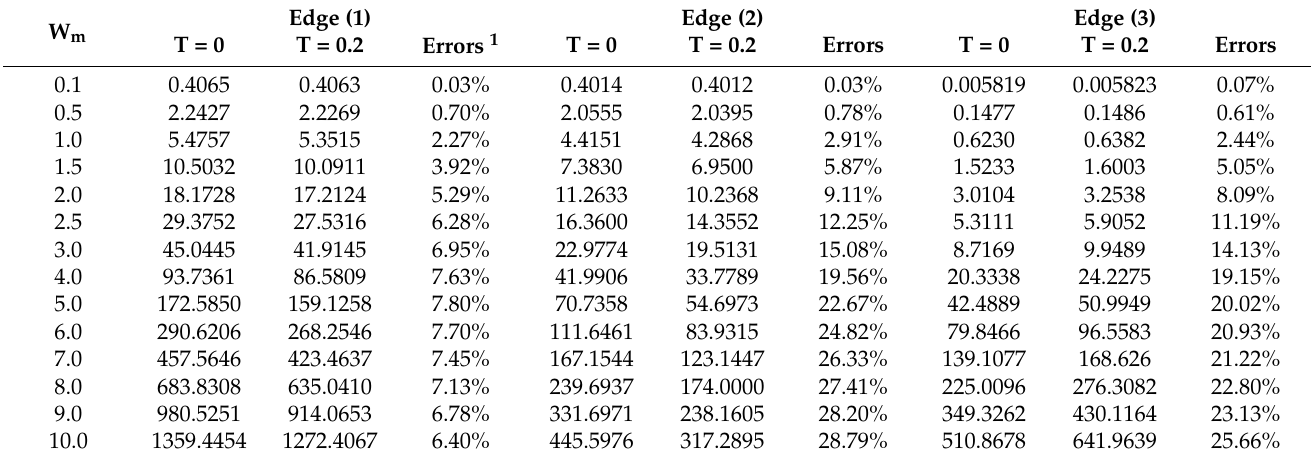
Figure 6. Variations of σ y a 2 / E 0 t 2 with W m at the edge. Table 4. Computational values of edge yield stress under Edges (1), (2), and (3).